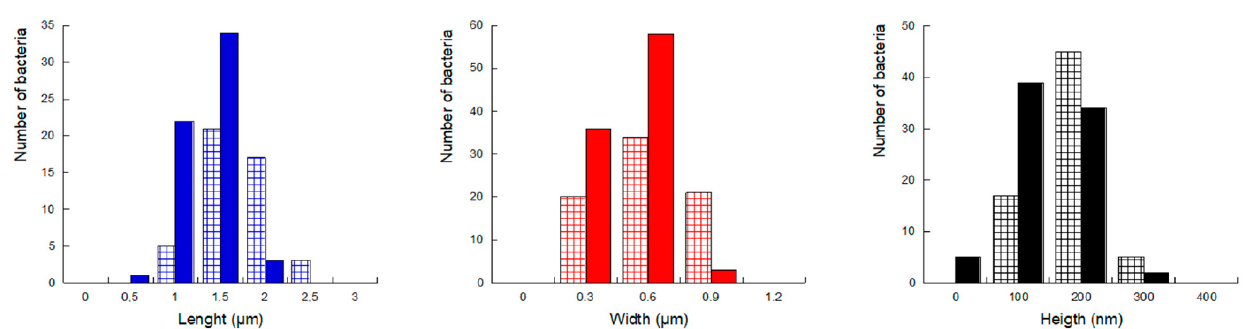
Figure 4. Histograms of P. fluorescens length (blue), width (red) and height (black). Measurements were performed on 120 aggregated cells (solid bars) and 40 isolated cells (hatched bars).